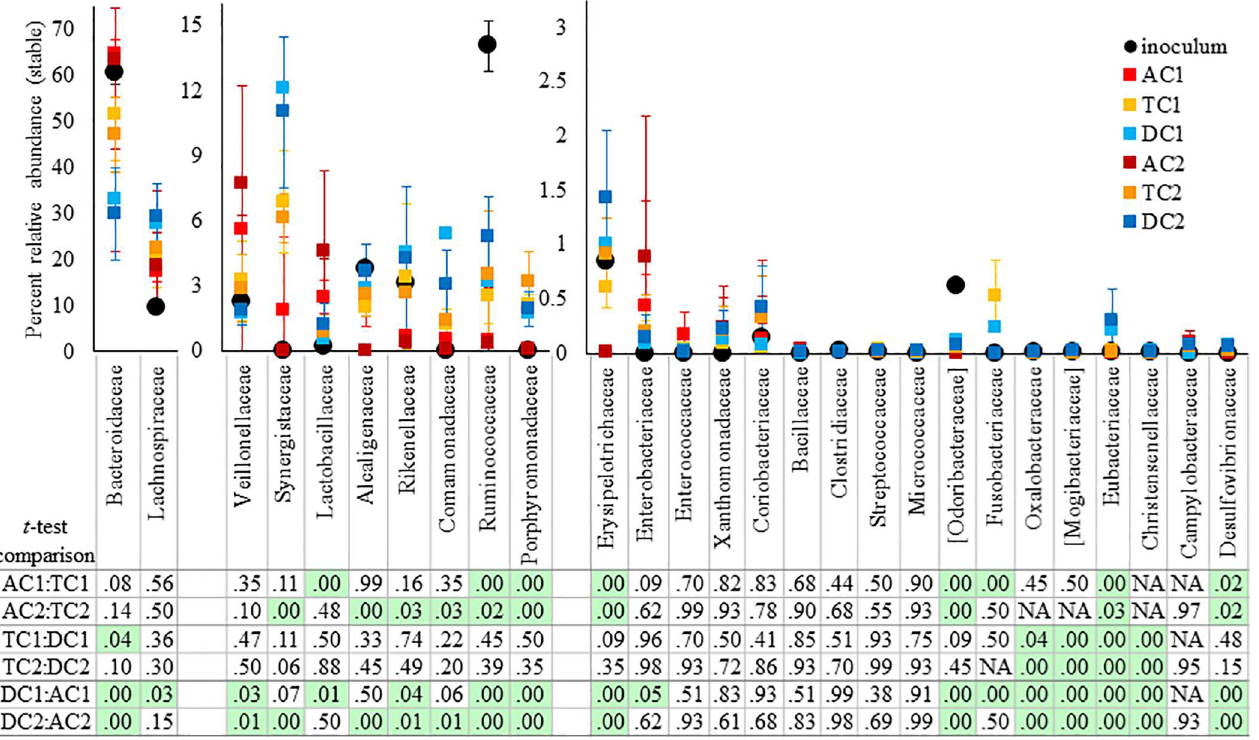
Fig 4. Comparison of relative abundance, at the family level, between the luminal phase of the AC, TC, and DC regions of each SHIME system after stabilization (Day10-Day 43). Only families with a greater than .01% relative abundance in at least one region were considered. The error bars represent the standard deviation between the percent abundance at these time points. The P values based on a 2 tailed student t- test between regions are listed in the bottom chart. The P values were corrected for multiple comparisons. A green box indicates that p < 0.05.